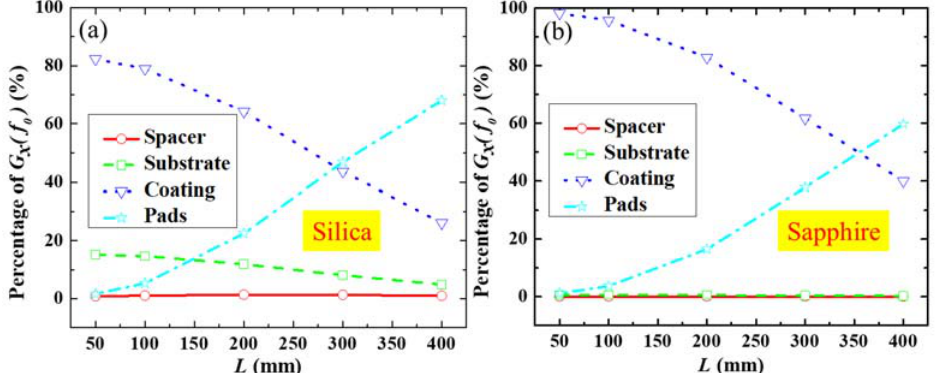
Figure 8. Percentage of contributions to the TN of the optical length Gx(f 0 ) as functions of the length L . The coating is GaAs/AlGaAs crystalline with the thickness d coa = 6.83 μ m cited from ref. [19]. The solid red line with circles denotes the spacer results. The dashed green line with squares denotes the substrate results. The dot blue line with triangles denotes the coating results. The dash–dot cyan line with stars denotes the four support pads’ results. ( a ) All ‐ silica USC. ( b ) All ‐ sapphire USC.